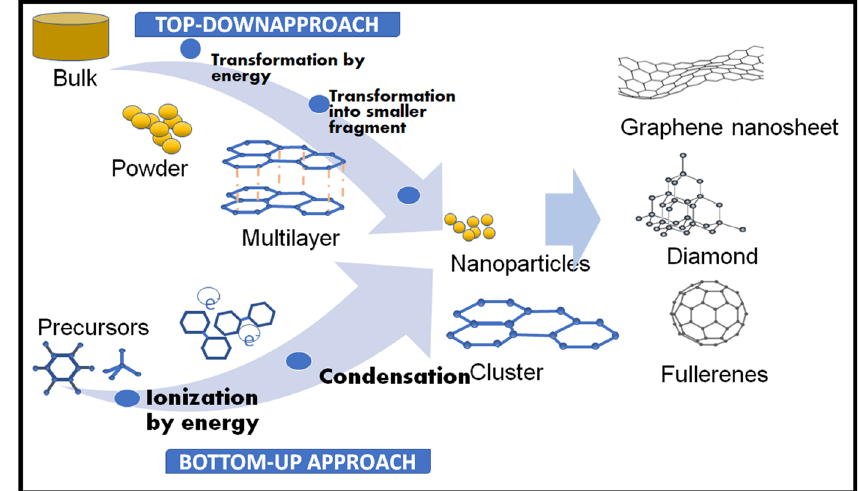
Figure 11: Schematic representation of the formation of highly × rGO from graphite using the top - down approach.